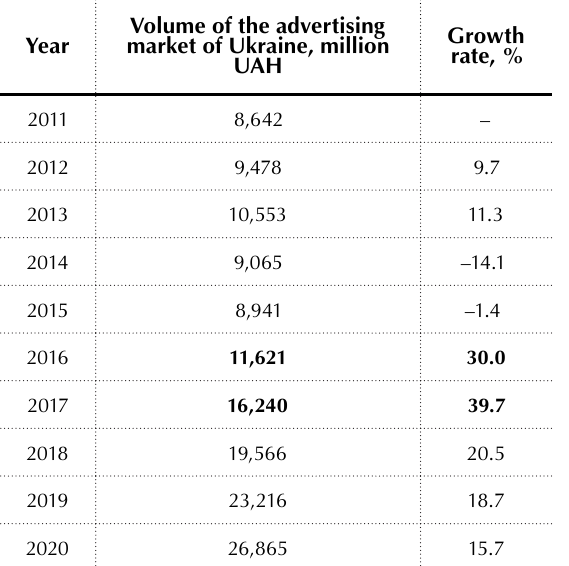
Table 5. The dynamics of change of volume of the advertising market of Ukraine during the period 2011−2018, million UAH